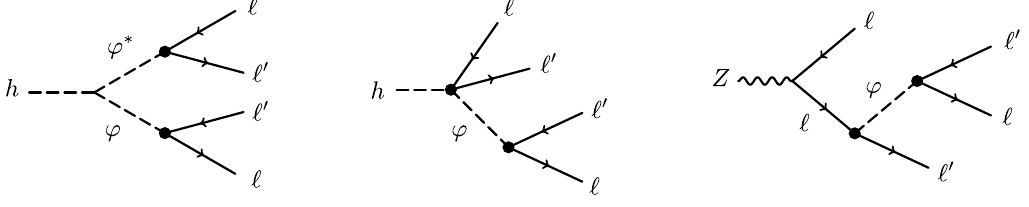
Figure 3 . Feynman diagrams for the processes listed in table 2: the dominant diagram for the case with a non-zero quartic coupling (cid:20) 6 = 0 (left), the main decay channels involving the Higgs (middle), and Z boson (right) in the case with (cid:20) =